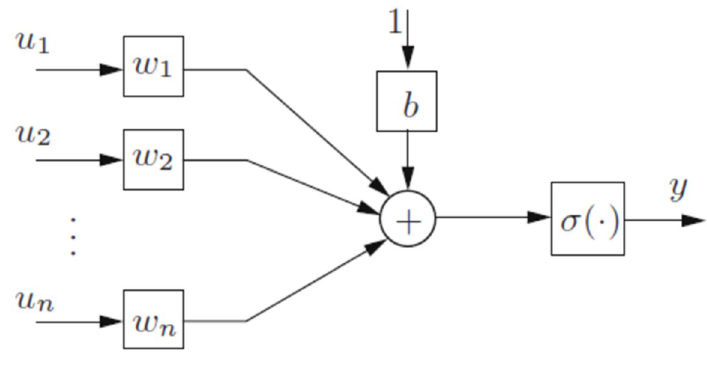
Figure 4. Neuron model.